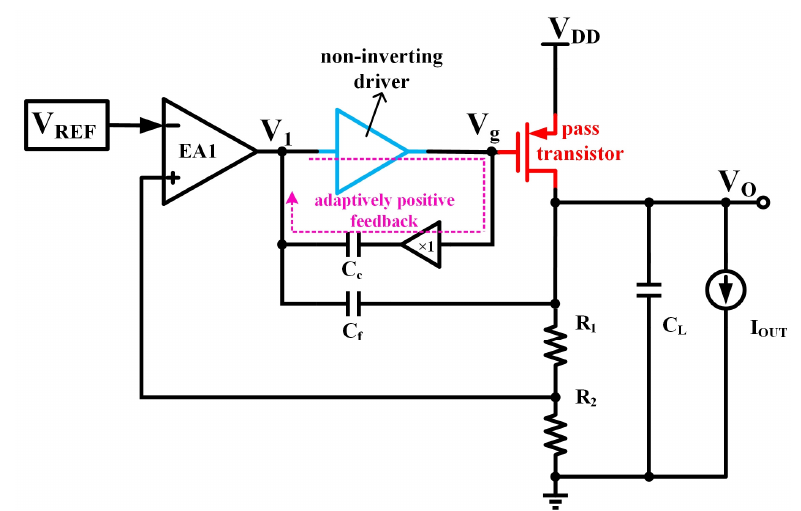
Figure 1. The proposed LDO structure with adaptive positive feedback compensation.